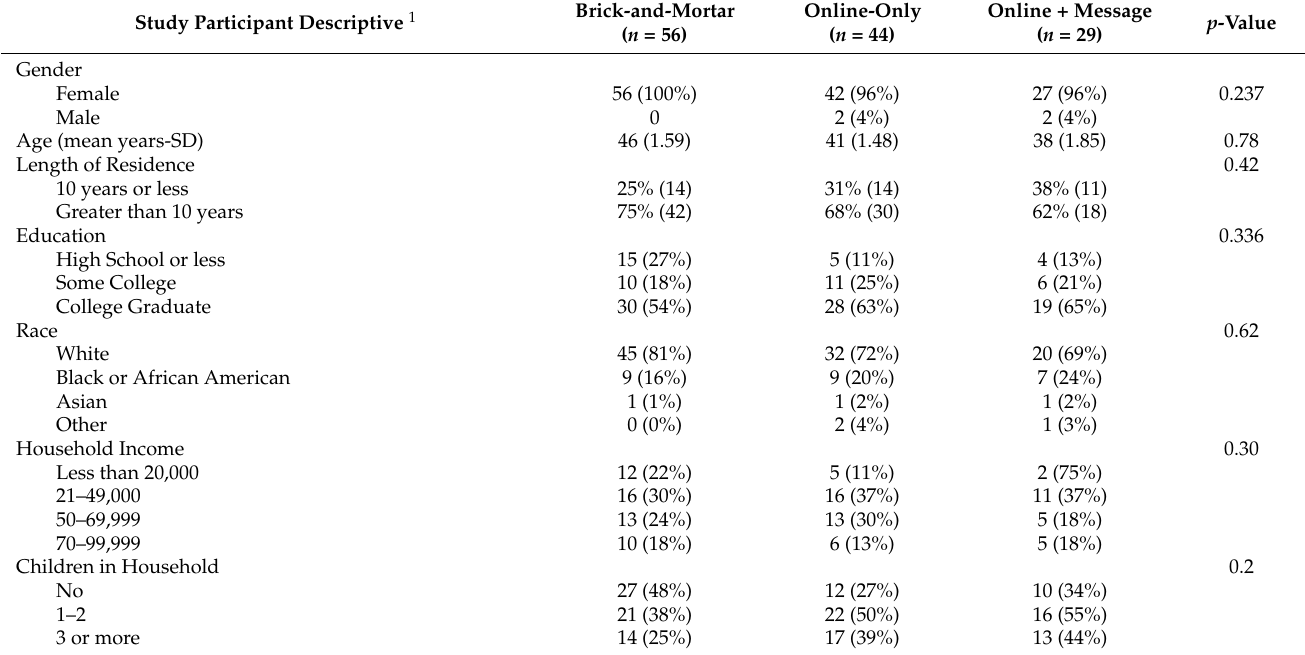
Table 2. Demographics of study participants across study arms of intervention ( n =